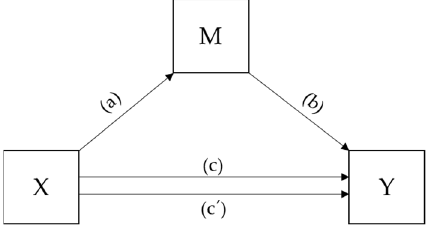
Figure 2. Figure 2. A theoretical model linking a cause (X) to an effect (Y) through a mediator (M). c = c’ + ab; c = total effect of X on Y; c´ = direct effect of X on Y; ab = indirect effect of X on Y through M.